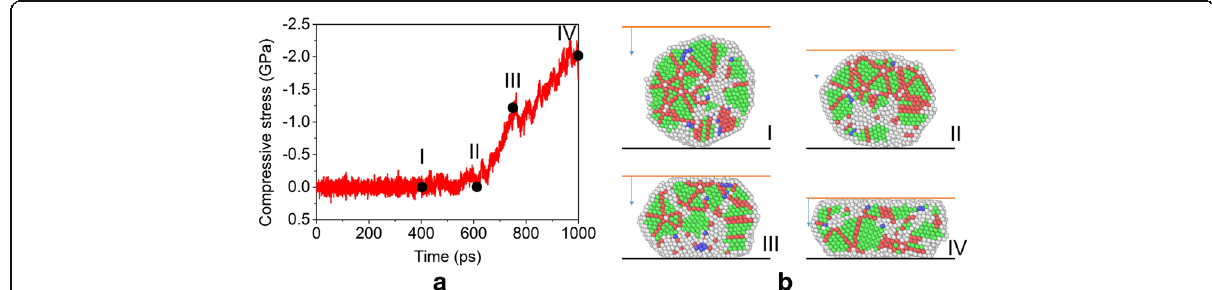
Fig. 9 Compressive test of sintered nanoparticles. a Compressive stress as a function of time for the final sintered particle. b Nanostructures at I 400 ps, II 610 ps, III 760 ps, and IV 1000 ps, in which solid lines represent rigid wall ( black ) and planar indenter ( red ) and the arrow indicates the moving direction of the